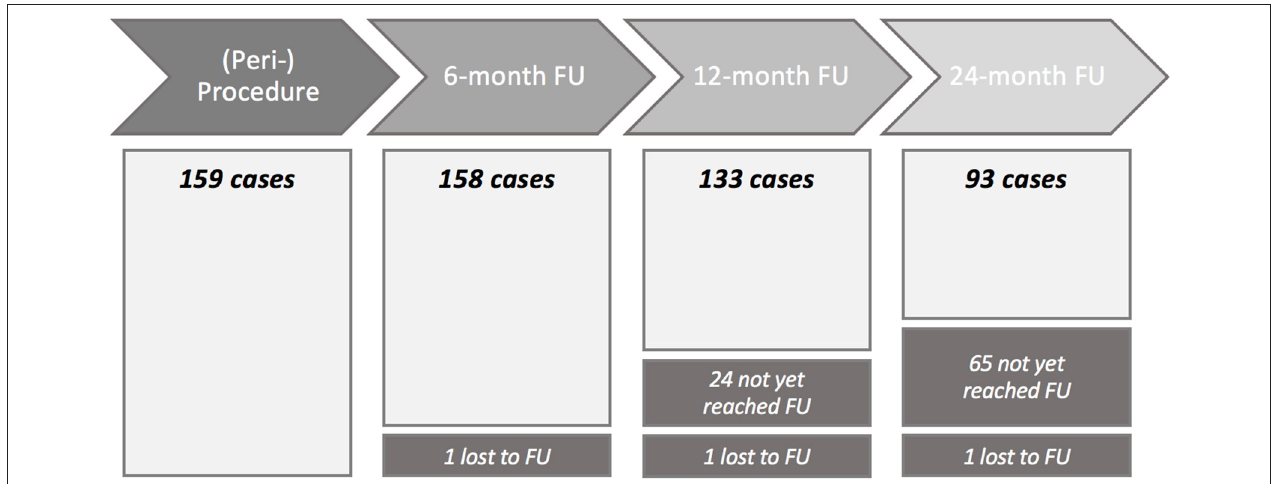
FIGURE 1 | Flowchart of cases included into the analysis at each time point. FU, follow-up.